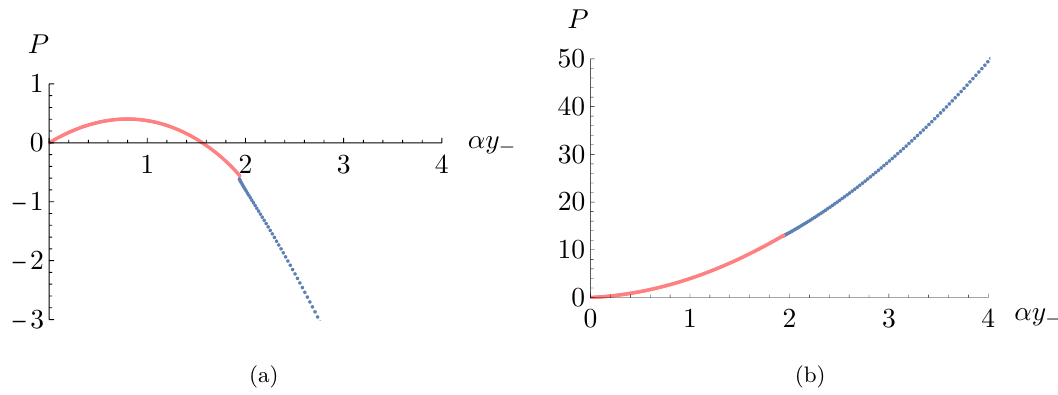
Figure 9. The shifted vev P = p − c 1 in two renormalization schemes ( a ) a scheme with b 3 < 0 and b 1 = 3 which leads to the boundary condition p ( ∞ ) = −∞ ( b ) a scheme with b 3 > 0 and 2 b 1 = 3 so that p ( ∞ ) = ∞ . In the scheme ( a ) , the vev is multi-valued, while in the scheme ( b ) , it is 2 single-valued (modulo local effects near the phase